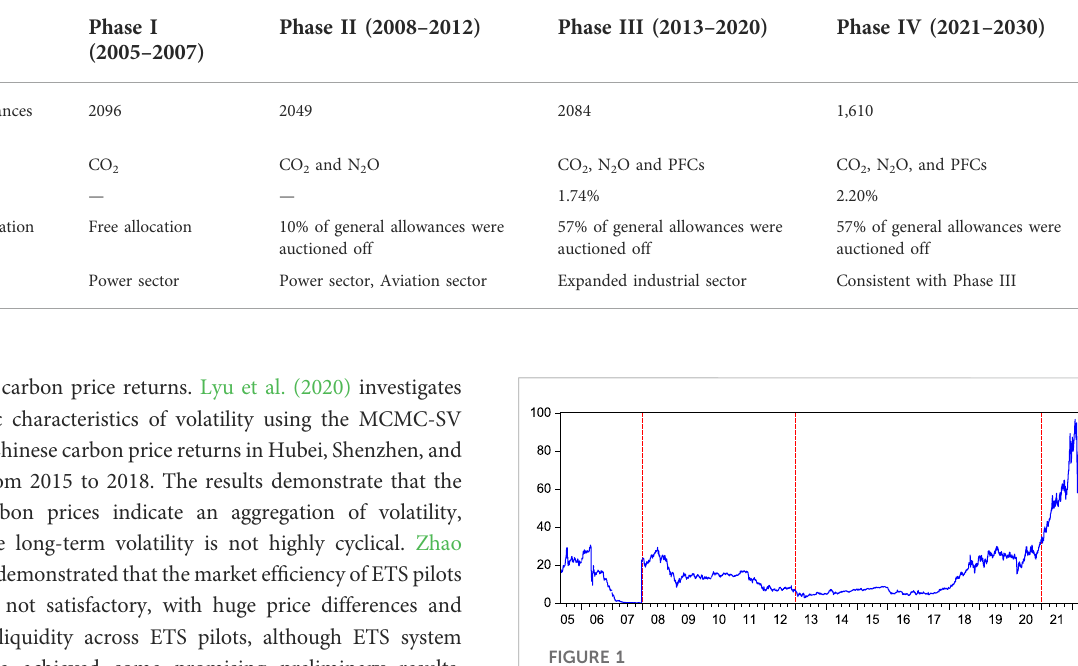
FIGURE 1 Price trends in EUA futures. The vertical lines mark the beginning of the different phases: phase I (2005 – 2007), phase II (2008 – 2012),phaseIII(2013 – 2020),andphaseIV(2020 –